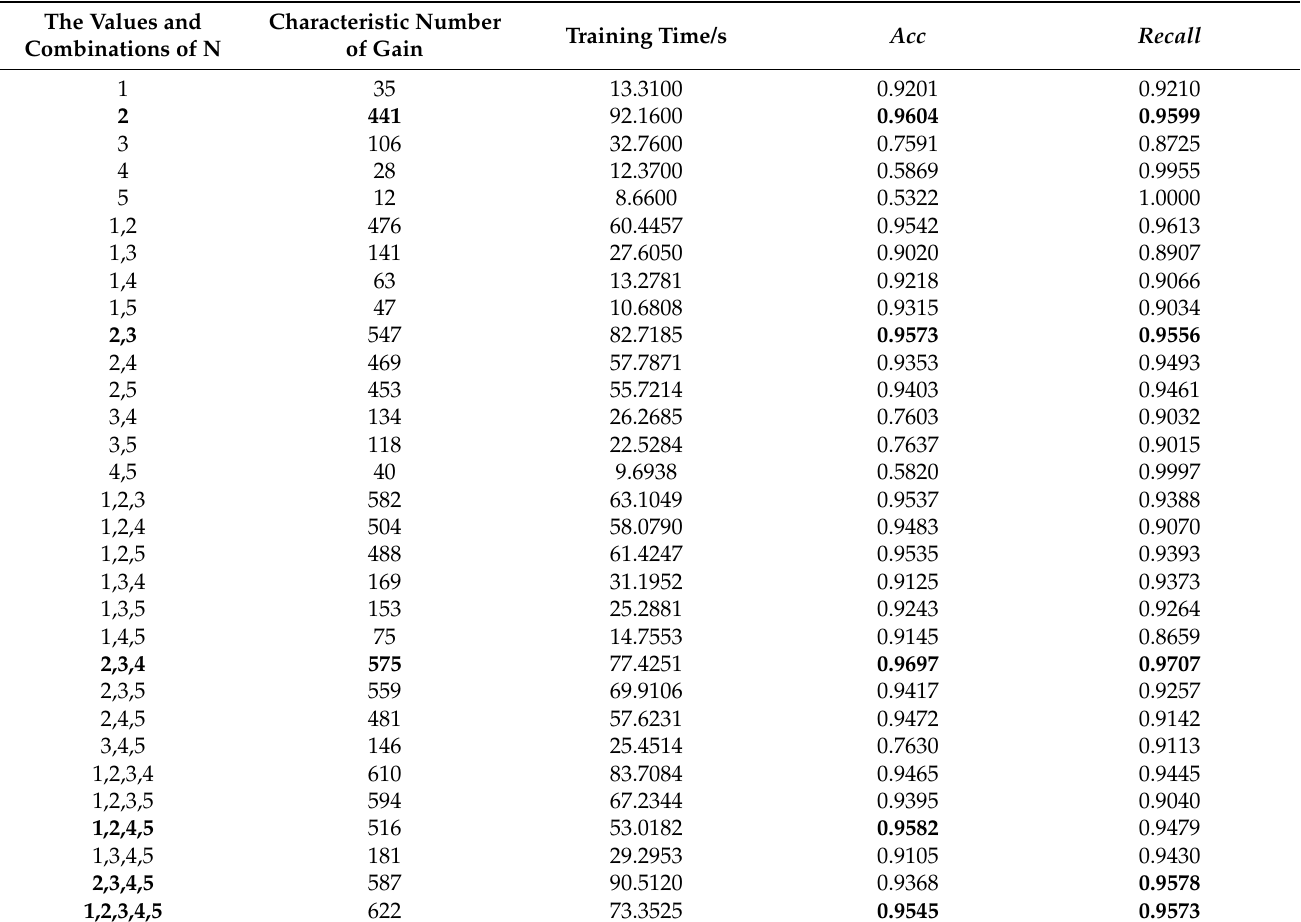
Table 4. Parallel detection model combination. Experiments were performed for possible N-Trans combinations. The experiments compared the number of features obtained from model training, training time, accuracy, and recall. N was too large ( N > 5) to cause the algorithm to proceed properly, so the corresponding experiments were not